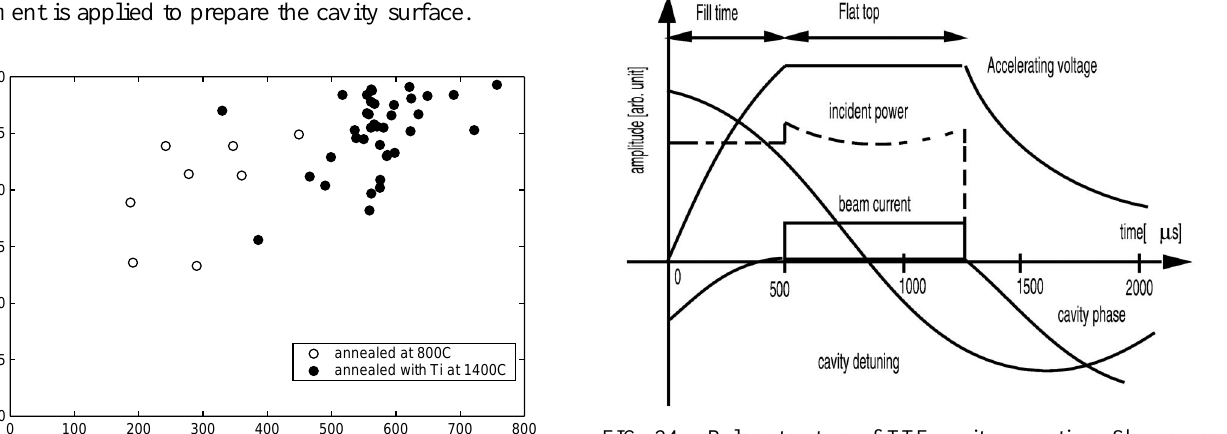
FIG. 24. Pulse structure of TTF cavity operation. Shown are accelerating voltage with 500 m s filling time and 800 m s flattop, incident power, beam current, cavity phase, and cavity